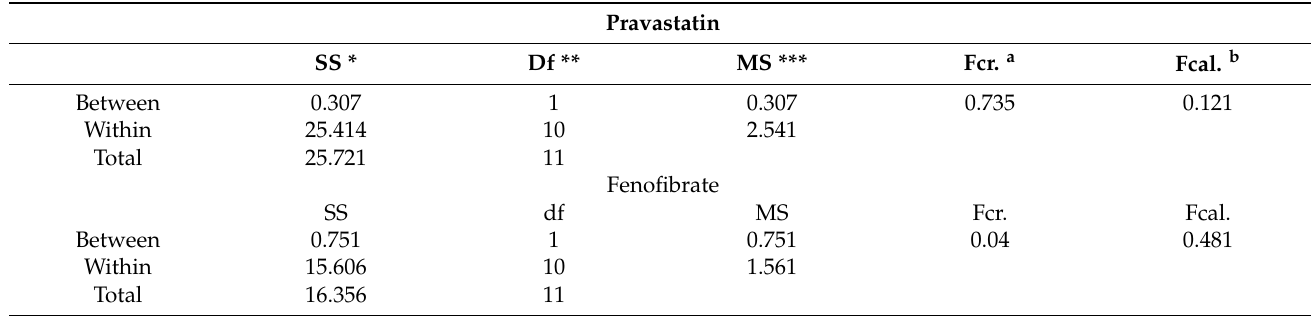
Table 7. Comparison of the established methods by one